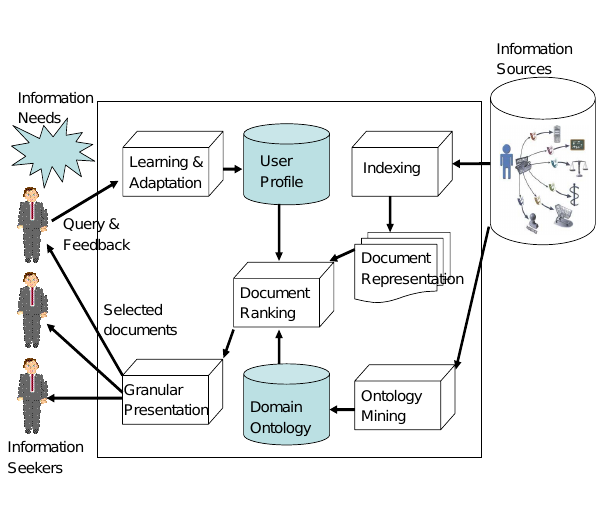
Fig. 1. The System Architecture of the Granular IR